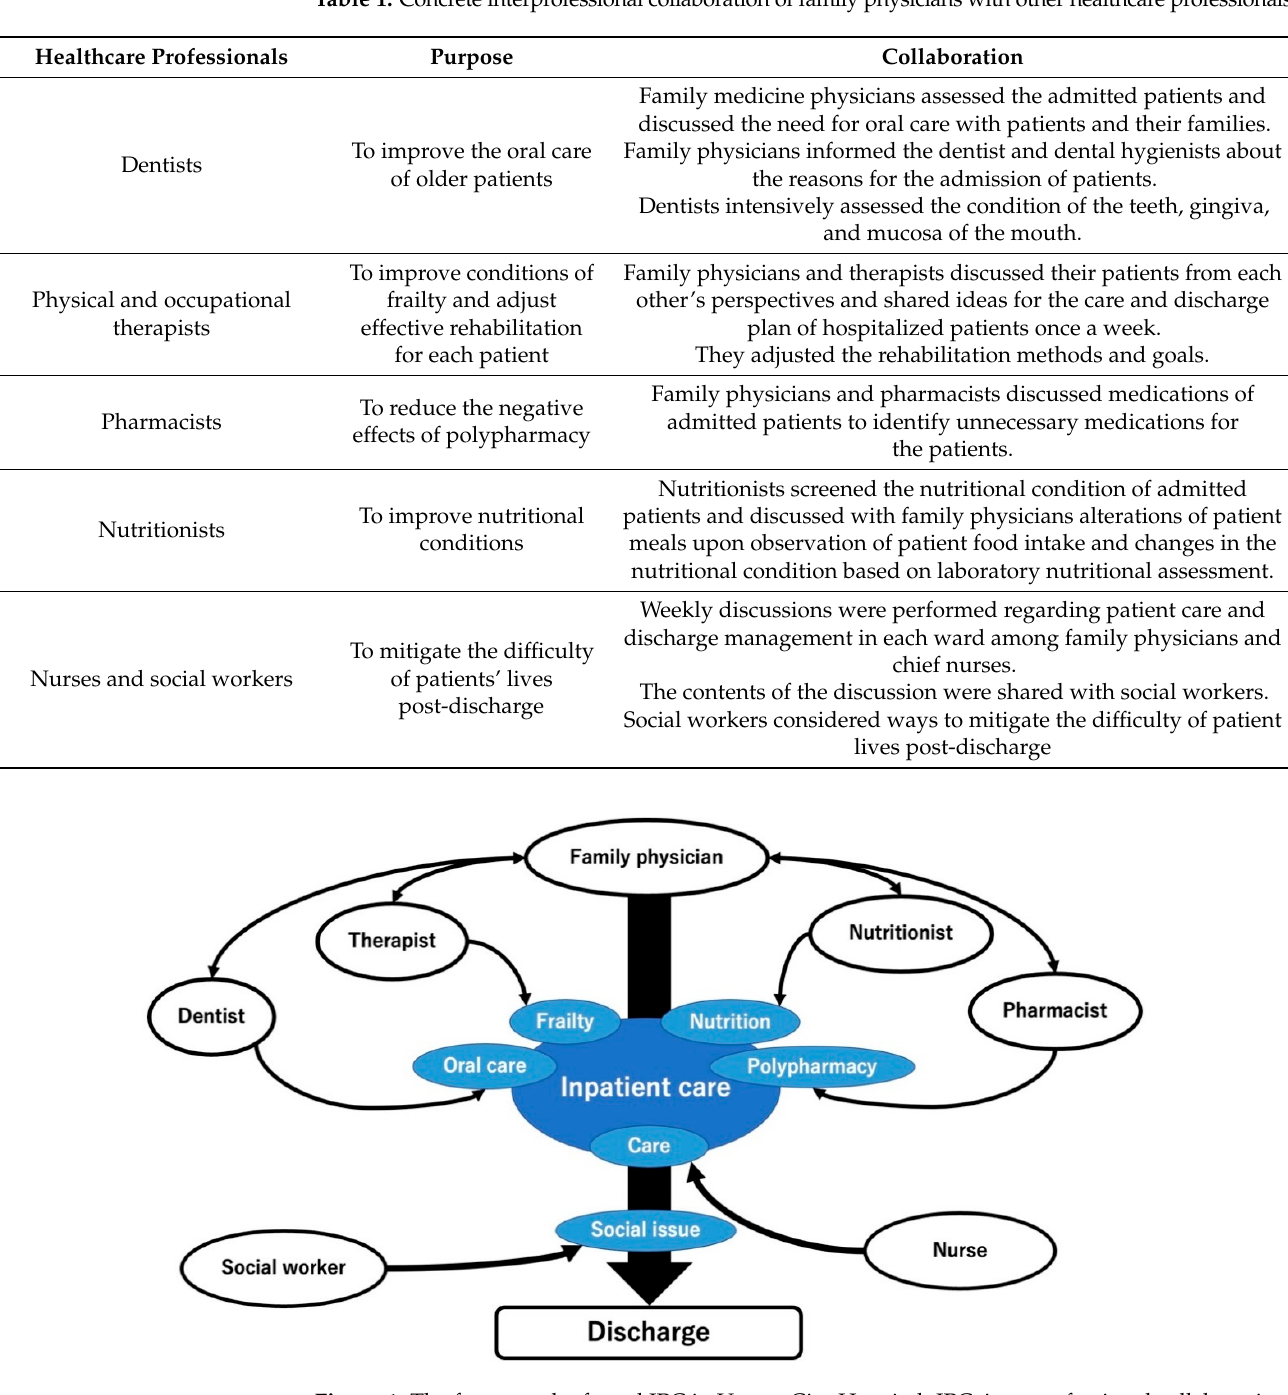
Figure 1. The framework of rural IPC in Unnan City Hospital. IPC, interprofessional collaboration.